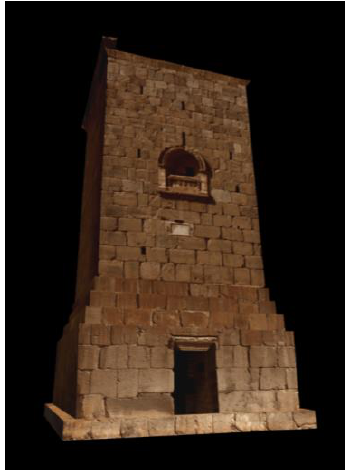
Figure 15 - Monumental tomb (Plot and render by M.Franca) http://youtu.be/1flZFgsmOzY